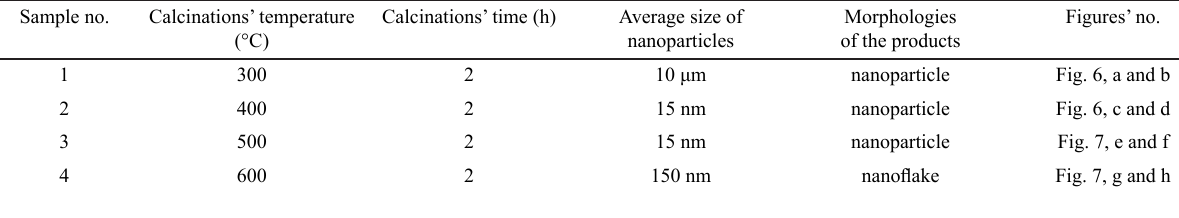
Table. 1. Products obtained under different calcination conditions. Sample